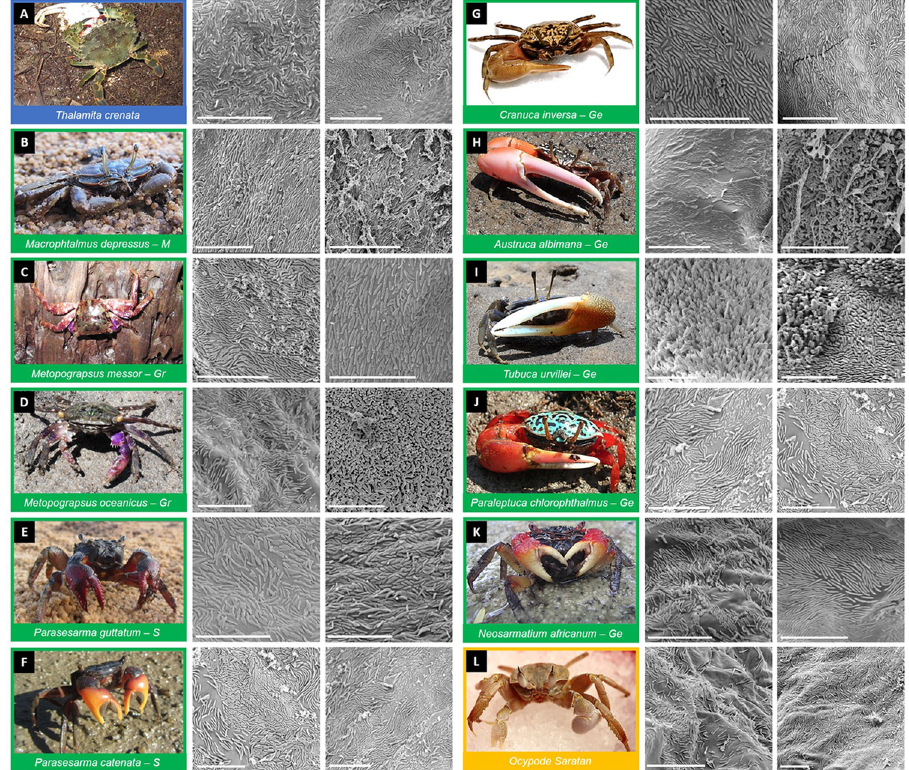
Fig 1. Prokaryotic colonization imaging of crab gills. Two representative SEM images of the microbial communities associated with gills are shown for each of the 12 crab species studied ( A – L ). The colours indicate the intertidal level inhabited: Blue subtidal, green = intertidal, yellow = supratidal. Letters in intertidal species show define each taxon- related intertidal group: Gr = Grapsidae, Ge = Gelasminidae, M = Macrophtalmidae, S = Sesarmidae. Scale bar corresponds to 10 μ m (photo credit and copyright: Marco Fusi A-F , H-K, and Elisa Garuglieri G, L . Marco Fusi and Elisa Garuglieri publish these pictures under a CC BY licence).